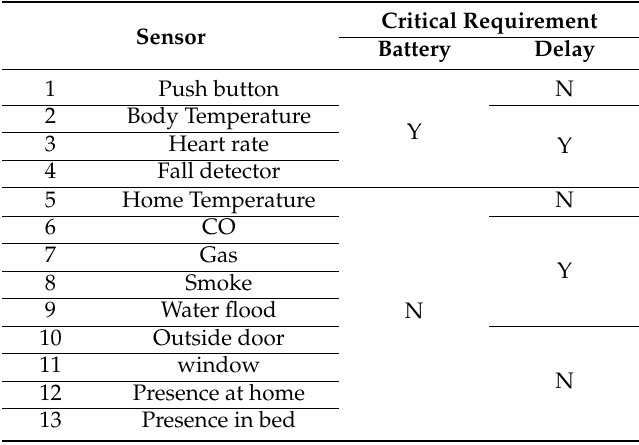
Table 10. Restrictions and limitations.